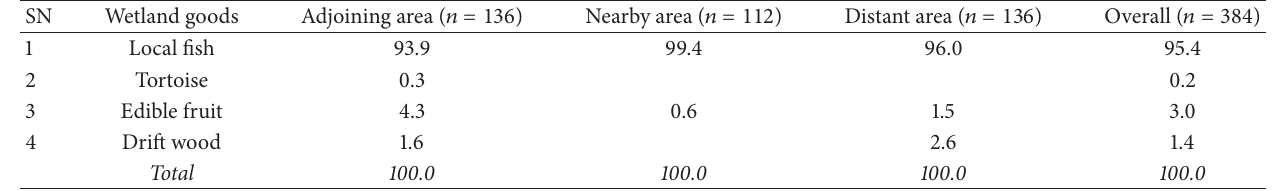
Table 6: Share of different value of wetland goods consumed.